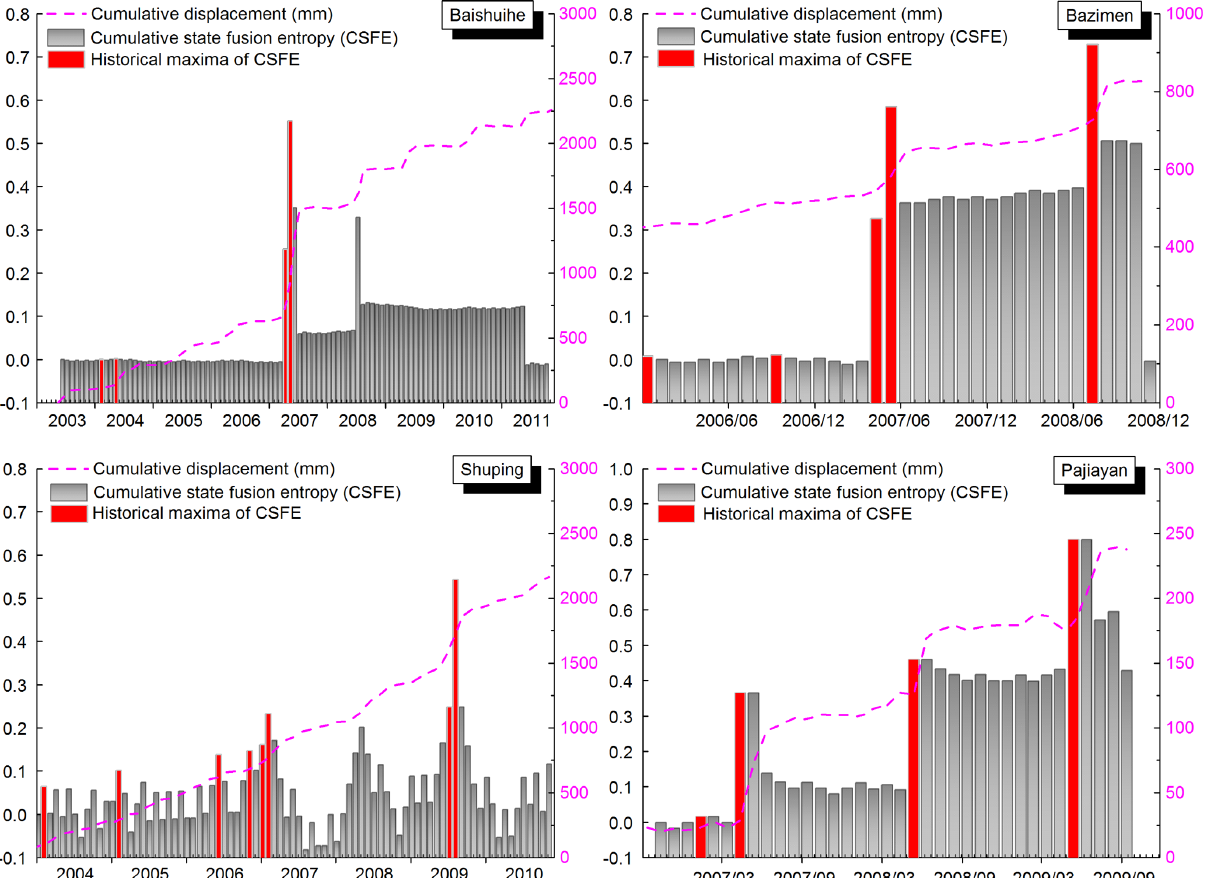
Figure 9. Cumulative state fusion entropy and historical maxima of Baishuihe, Bazimen, Shuping and Pajiayan